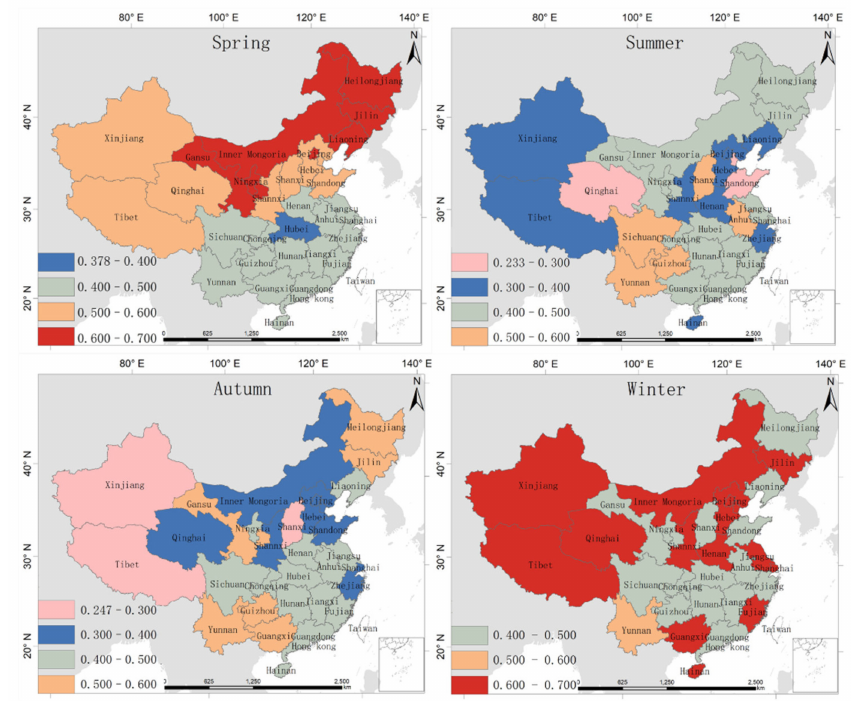
Figure 2. Local R 2 distributions of the GWR model in each